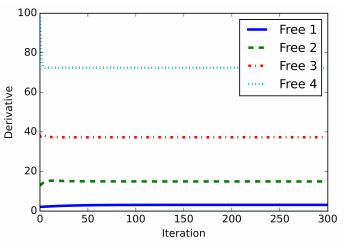
( k ) ) with respect to a c